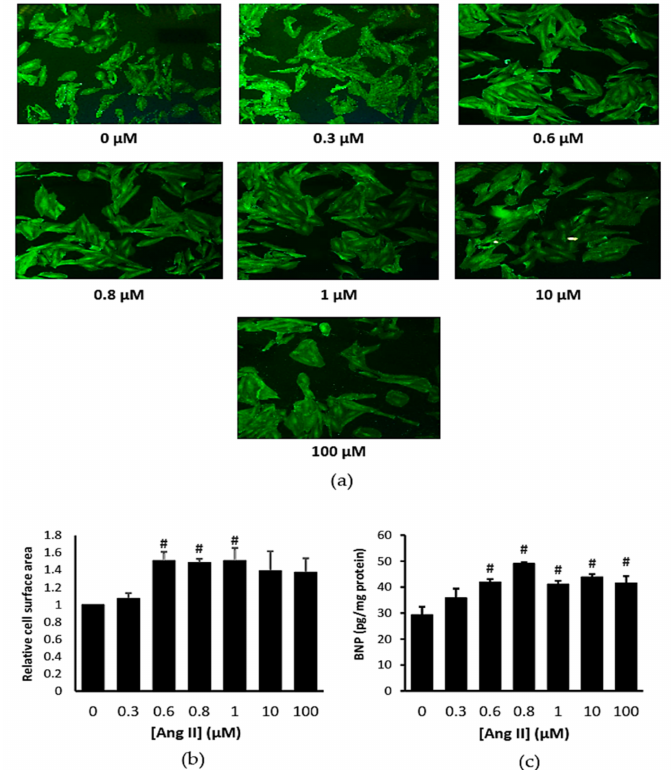
Figure 1. ( a ) Representative immunofluorescent staining (magnification × 100), ( b ) cell surface area, and ( c ) B-type natriuretic peptide (BNP) level in H9c2 cells exposed to Ang II at various concentrations for 24 h. # p < 0.05 versus control group. Data were analyzed by a one-way ANOVA followed by a Tukey post hoc test and are represented as the mean ± SEM ( n = 3).